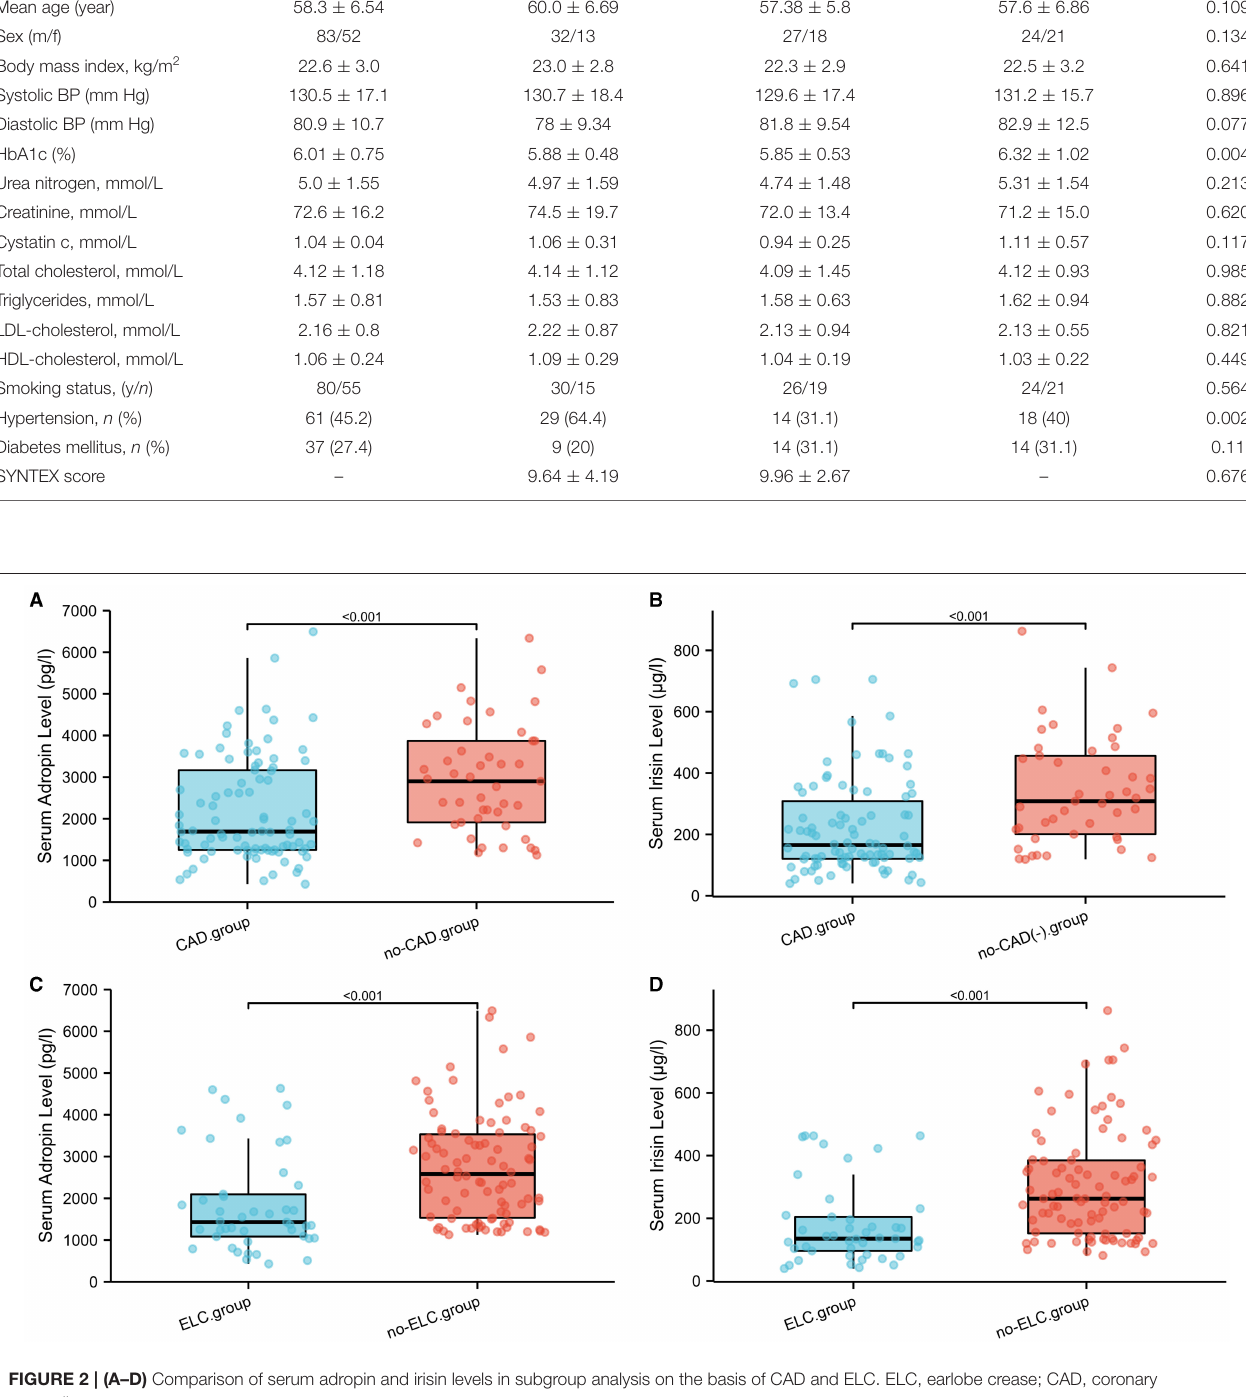
Frontiers in Cardiovascular Medicine | www.frontiersin.org